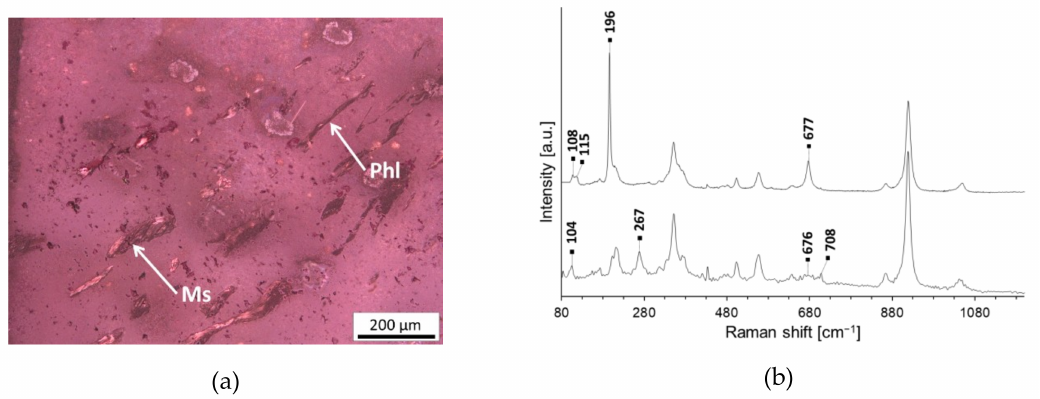
Figure 14. Xenomorphic grains in garnet G2 of fibula NA806. ( a ) Xenomorphic inclusions of mica (i.e., muscovite or / and phlogopite). Reflected light, parallel polars; ( b ) Raman spectrum of muscovite (Ms, spectrum below)) and Raman spectrum of phlogopite (Phl, spectrum above) in almandine